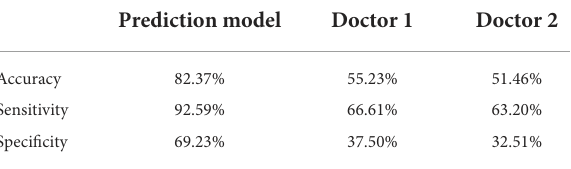
TABLE 4 The comparison of the prediction model with clinical assessment.